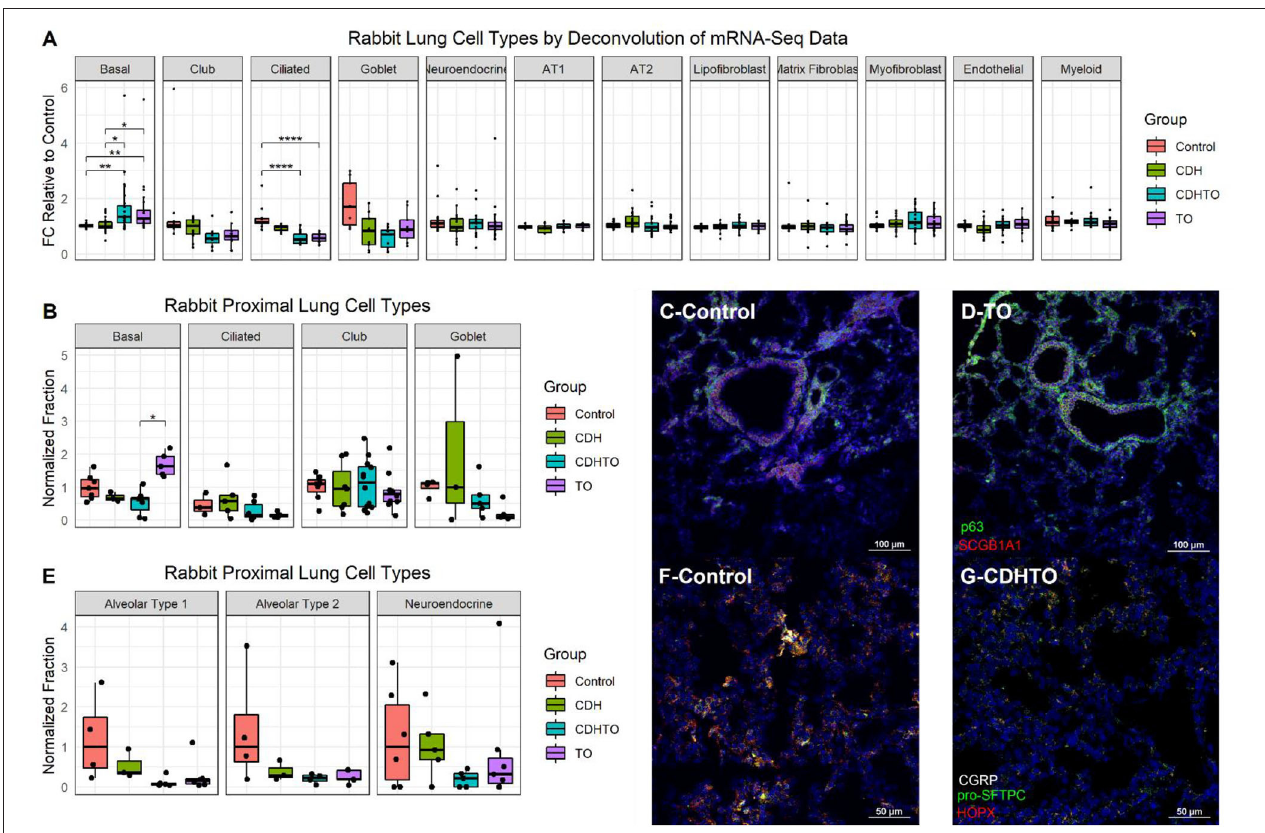
FIGURE 1 | Increased basal cells in a rabbit model of fetal tracheal occlusion. (A) Lung cell-specific mRNAs and the relative expression of each in rabbit fetuses with sham surgery, diaphragmatic hernia creation ( CDH ), tracheal occlusion ( TO ), or both ( CDHTO ) were identified. Each data point represents the relative expression of one gene per group ( n = 4 per group). This analysis identified a relative increase in basal cell- and a reduction in ciliated cell-associated genes. * p < 0.05, ** p < 0.01, **** p < 0.0001 by Dunn’s post-hoc test with Bonferroni correction. (B) Immunostaining and quantitative image analysis of the upper left lobe rabbit lung showing a relative increase in the number of basal cells as a fraction of the total cells in TO lung ( n = 4–6 per group). (C) The basal cell master regulator p63 was present in conducting airways of control rabbit fetuses largely below SCGB1A1-positive club cells. (D) The relative abundance of p63-positive cells was increased in the lungs of TO rabbit fetuses. (E) Apparent reductions of both alveolar type 1 and type 2 cells were not statistically significant. (F) Immunostaining for the alveolar type 2 cell marker pro-surfactant protein C (pro-SFTPC) and the alveolar type 1 cell marker HOPX in sham-treated fetal rabbit lung. (G) CDHTO lung appeared to have reductions in both